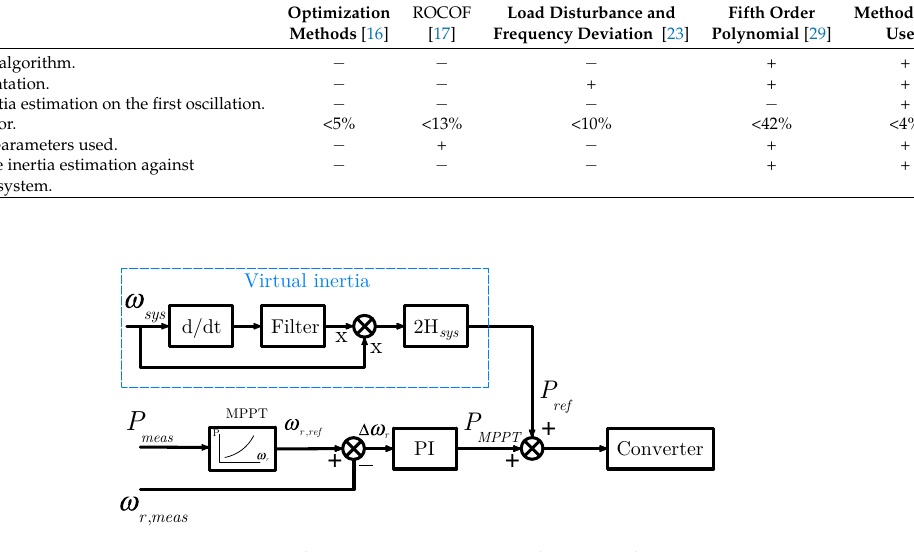
Figure 1. Virtual inertia concept in wind power